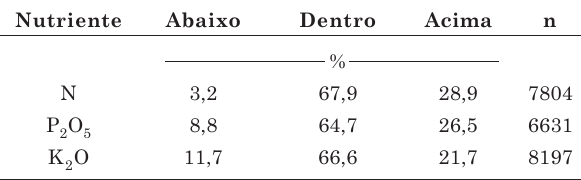
análise abaixo, dentro e acima do tolerado,